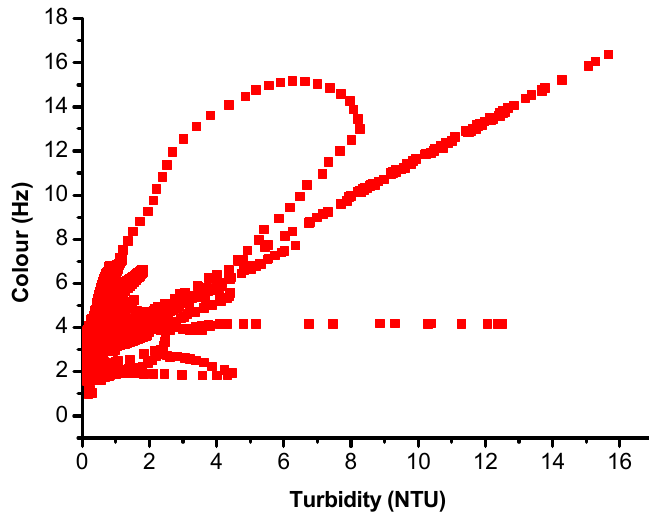
Figure 5. Graph of color with respect to turbidity.